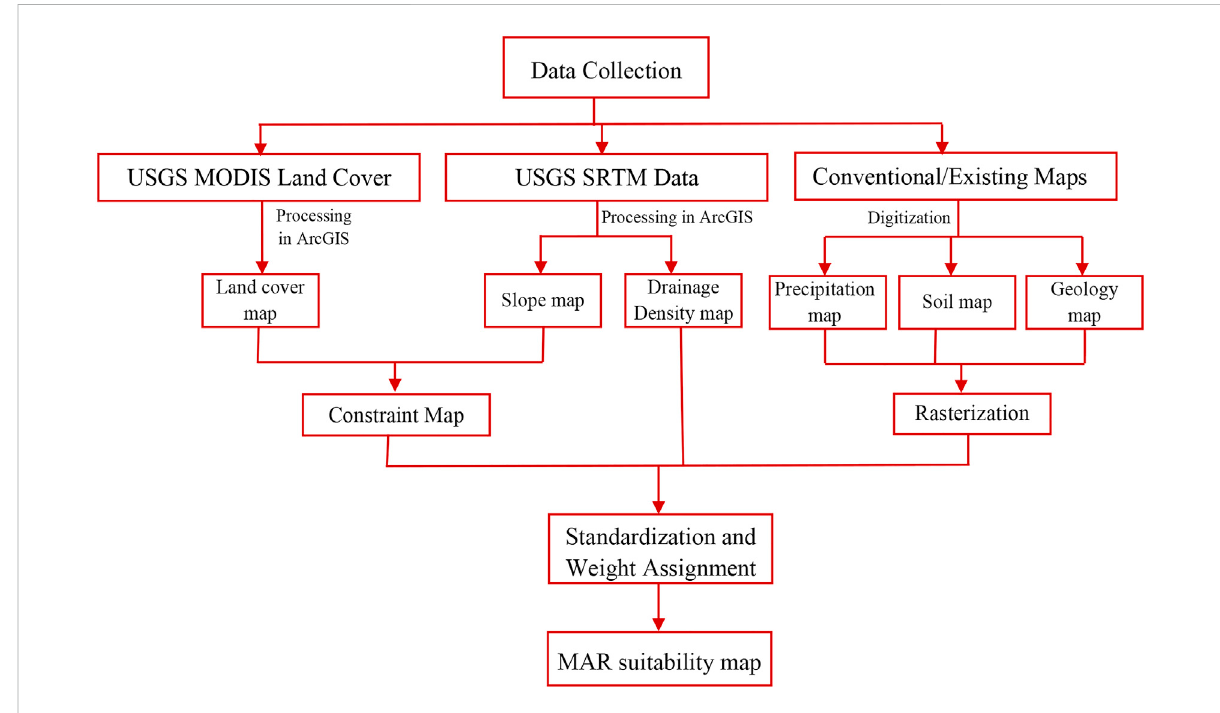
FIGURE 2 Work fl ow adapted for delineation of MAR suitability